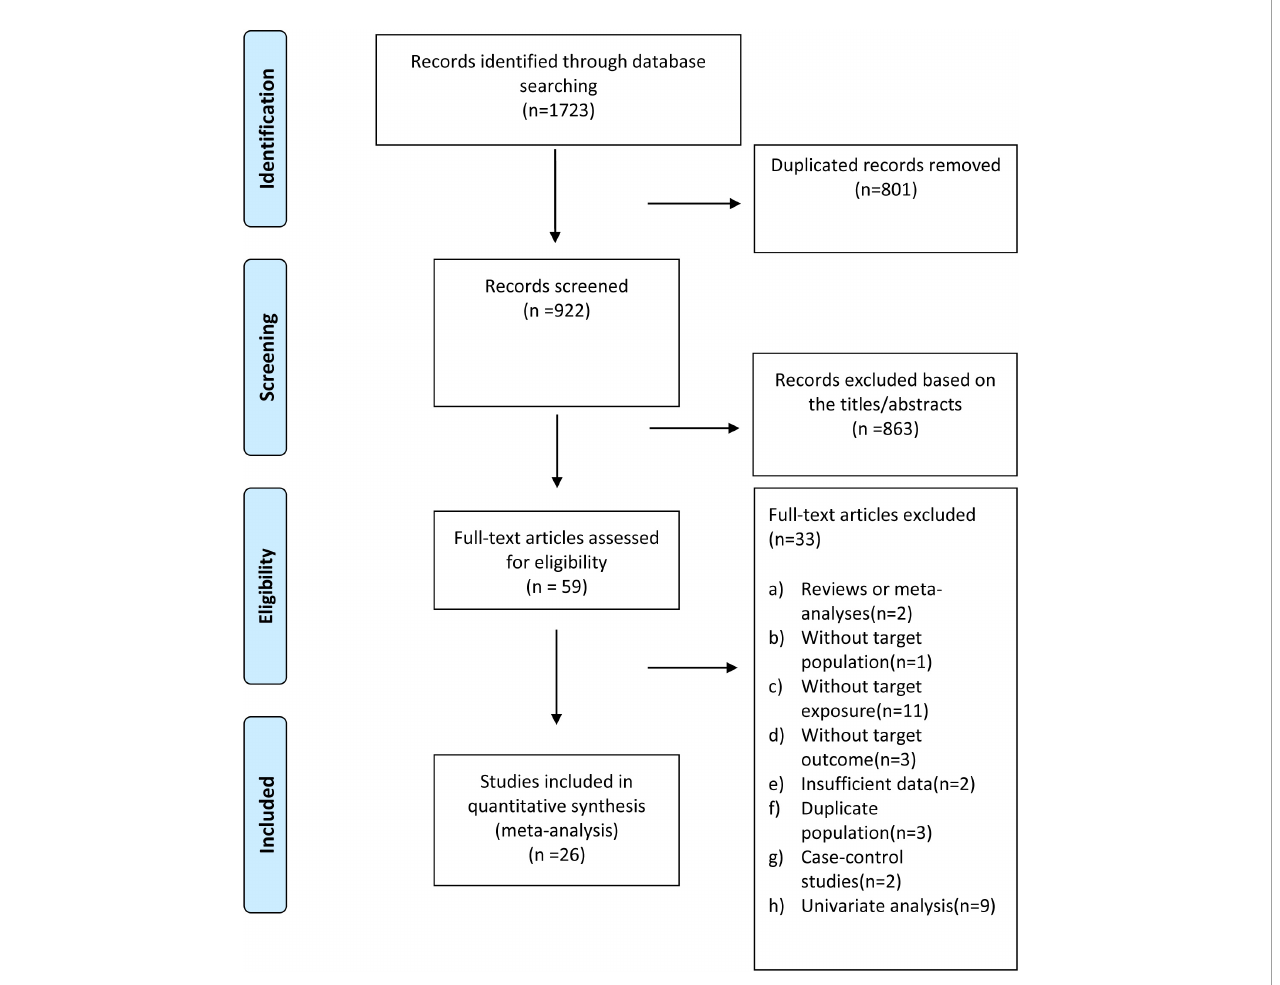
FIGURE1 Flow diagram of study selection for the dose-response meta-analysis of body mass index and atrial fibrillation recurrence in patients undergoing radiofrequency